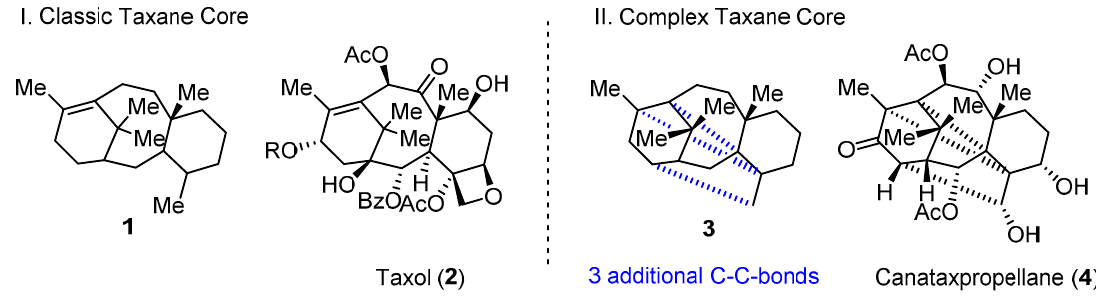
Figure 1. Comparison of the carbon backbone of taxol ( 2 ) and canataxpropellane ( 4 ).